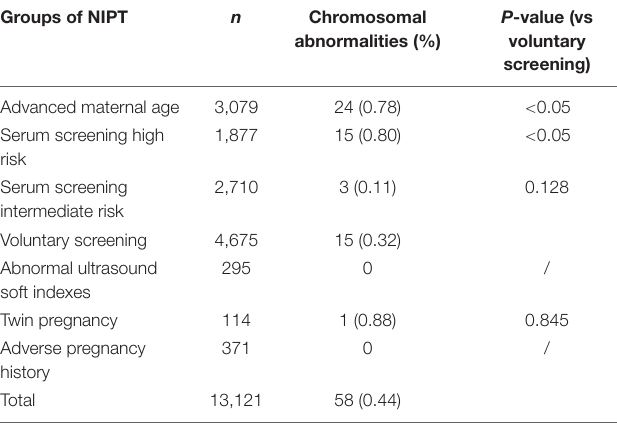
TABLE 2 | Detection rates of chromosomal abnormalities in different subgroups. Groups of NIPT n